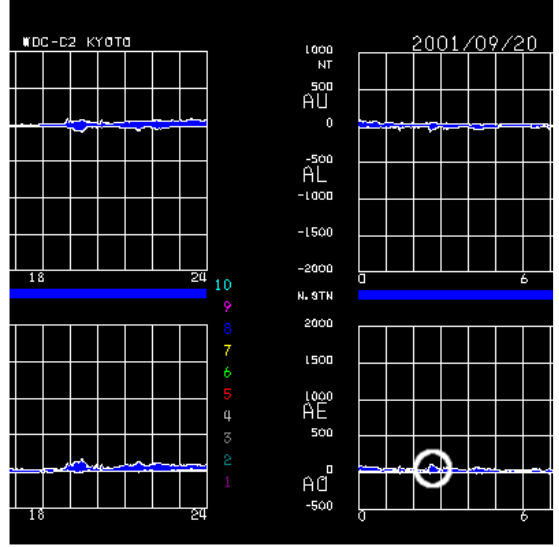
Fig. 2. Auroral activity indices, from the Data Service of World Data Center for Geomagnetism, Kyoto, http://swdcdb.kugi.kyoto-u. ac.jp (adapted). A small bump in AE, at the time of the conjunction, is indicated by a small circle. Its possible relevance is discussed in Sect.